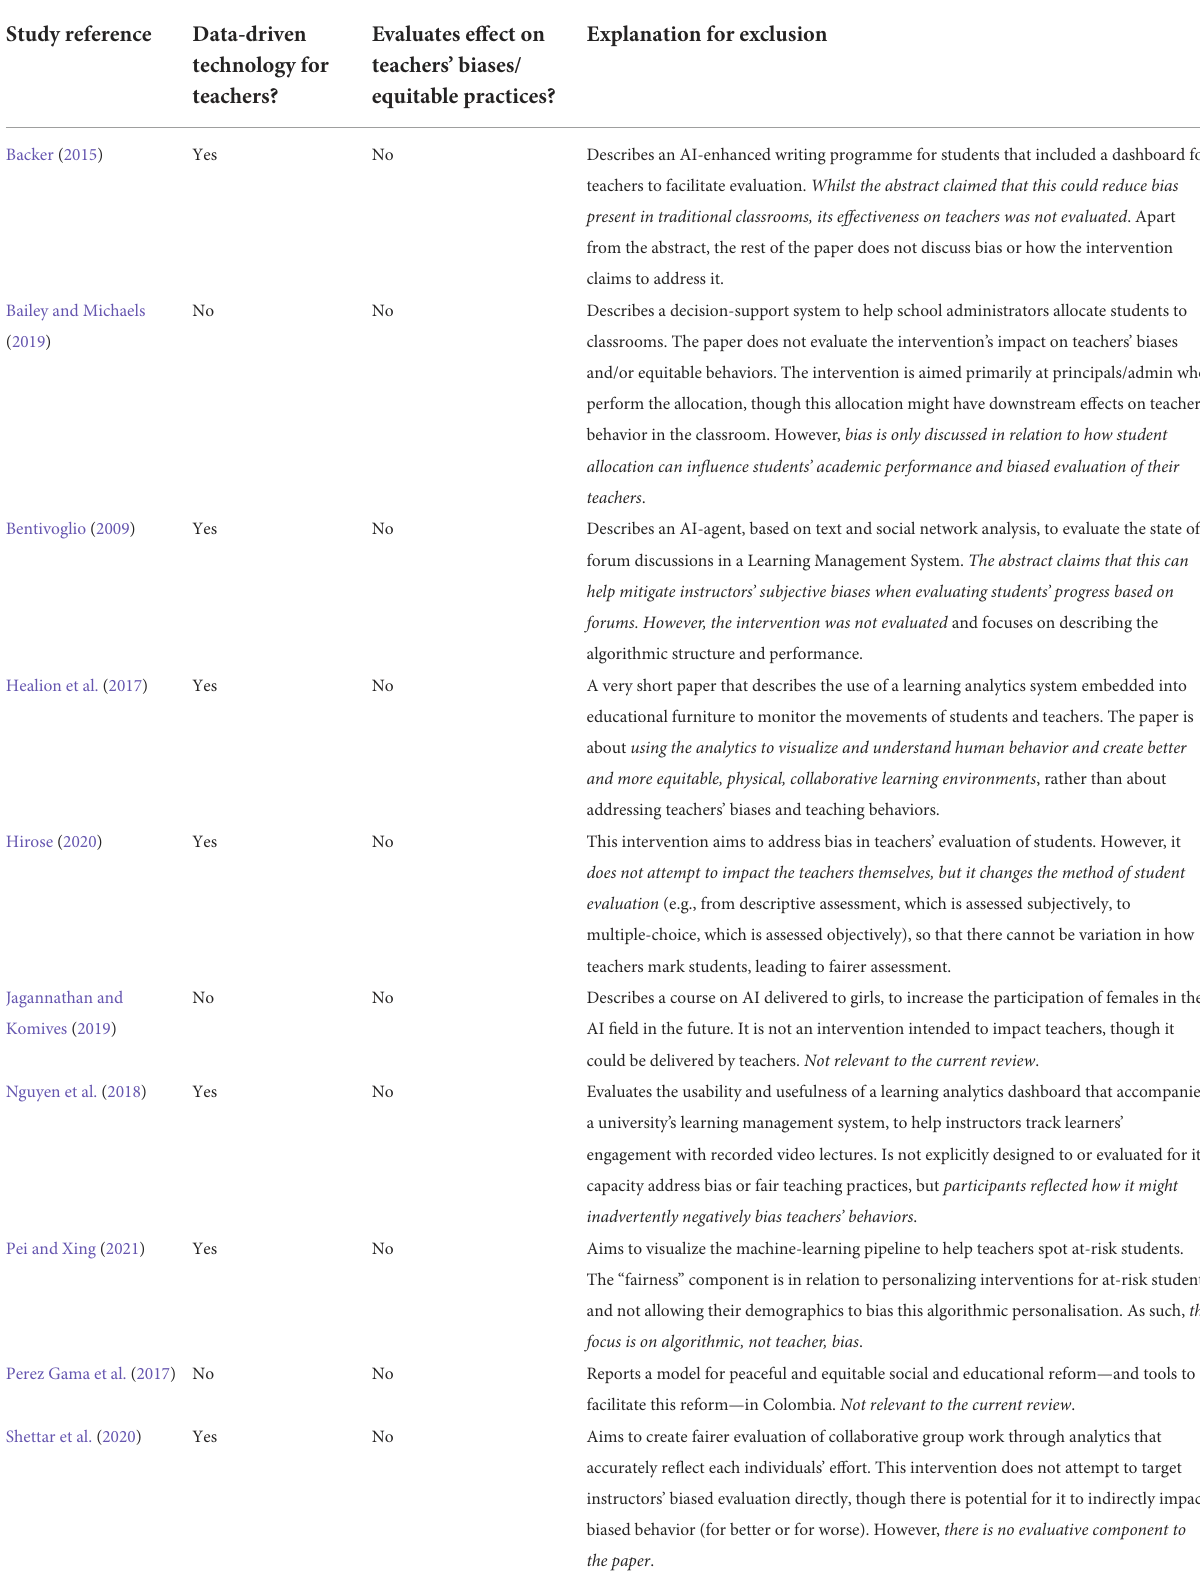
TABLE 2 Reasons for paper exclusion upon full-text